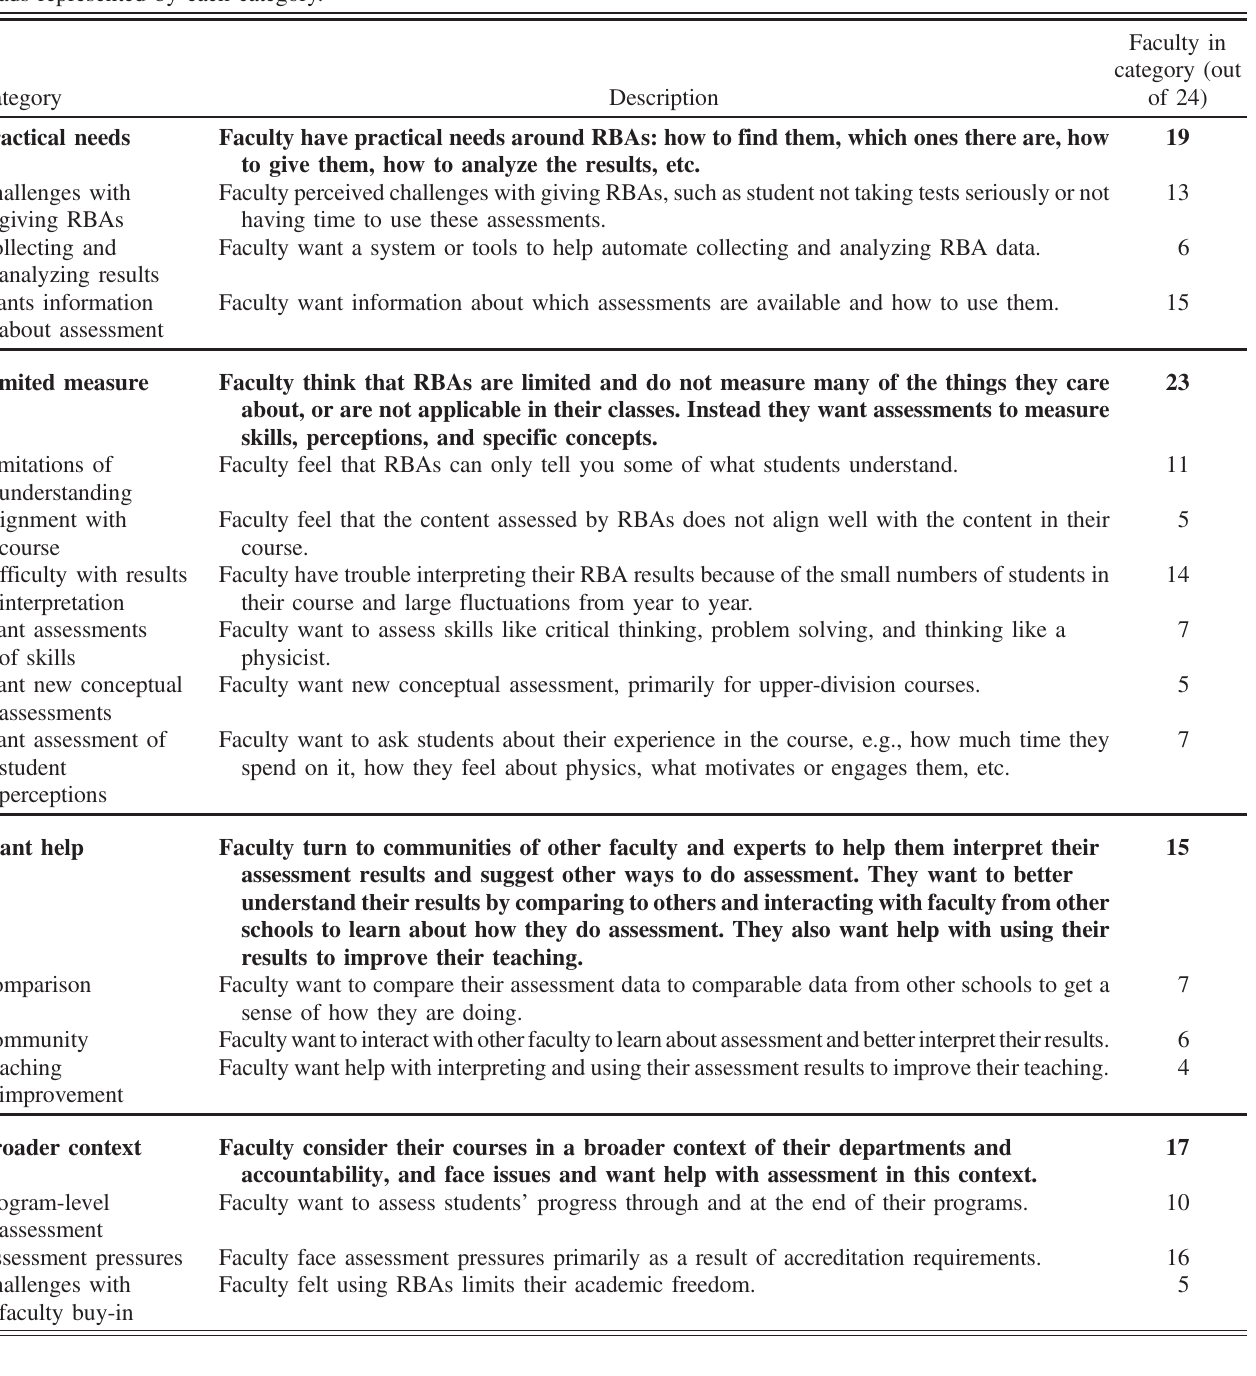
TABLE II. Descriptions of four major categories (in bold) and associated subcategories and number of ordinary faculty or department heads represented by each